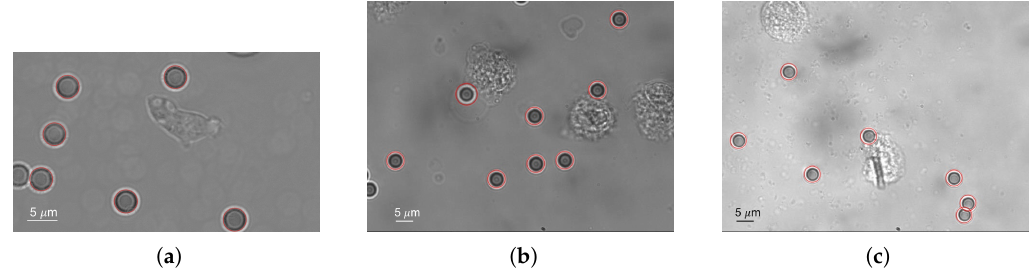
( x , y ) ; ( b ) I sw ( x , y ) ; ( c ) I sm ( x , y ) . jb jb jb